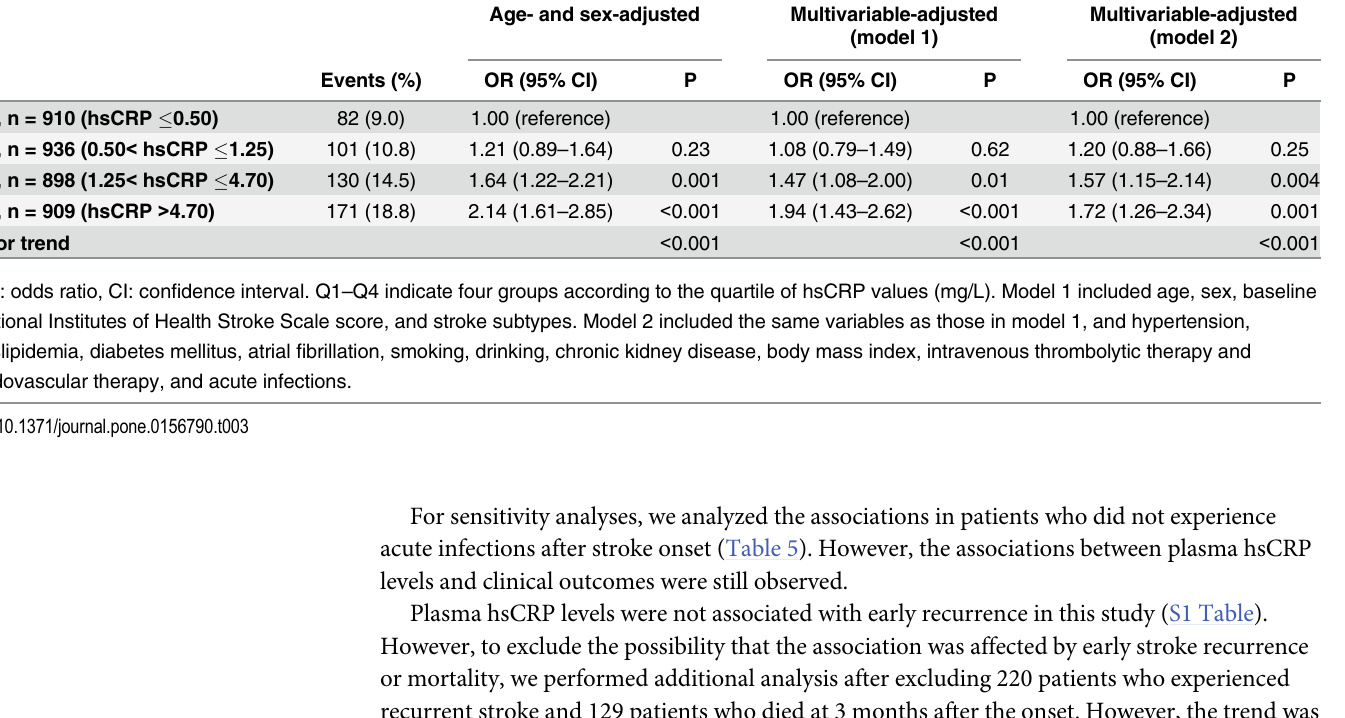
Age- and sex-adjusted Multivariable-adjusted (model 1)